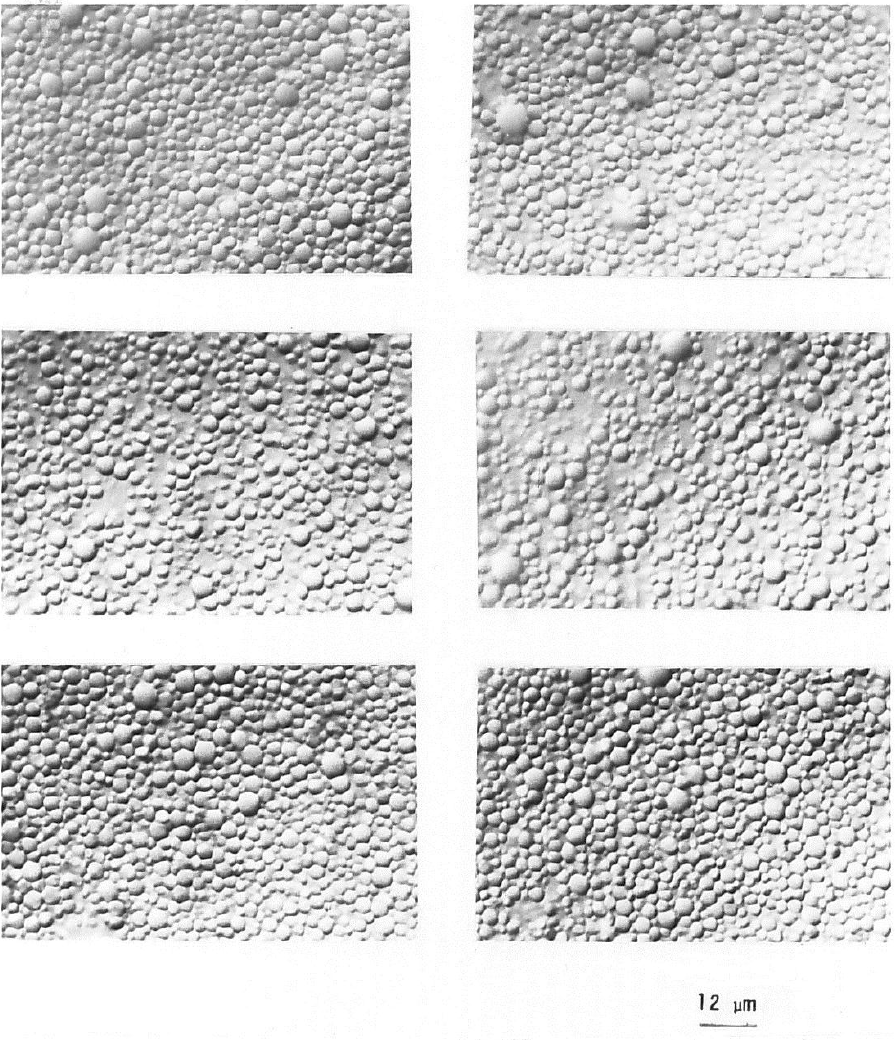
Figure 4. Typical photomicrographs of a 55.14% by volume O/W